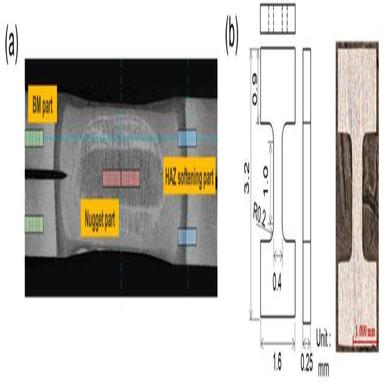
Miniature tensile test specimen. (a) Locations for extraction of miniature specimen, (b) dimensions of miniature tensile test specimen.